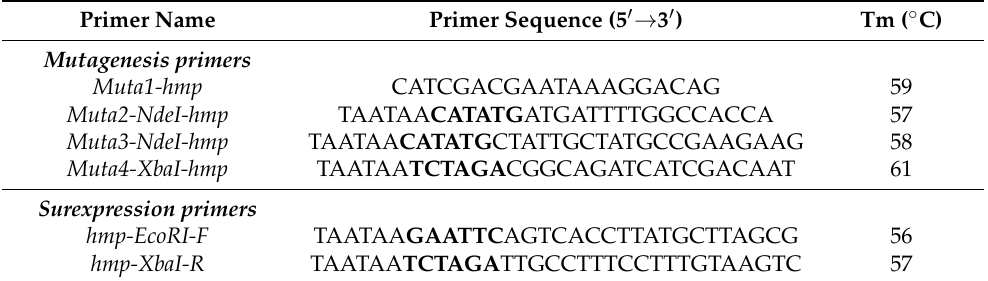
Table 2. List of primers used for the mutation of hmp in MFAF76a. In bold cases are represented the restriction site for Nde I, Xba I and Eco RI in primers Muta2-NdeI-hmp , Muta3-NdeI-hmp , Muta4-XbaI-hmp , hmp-EcoRI-F and hmp-XbaI-R respectively, Tm: hybridization temperature in Celsius